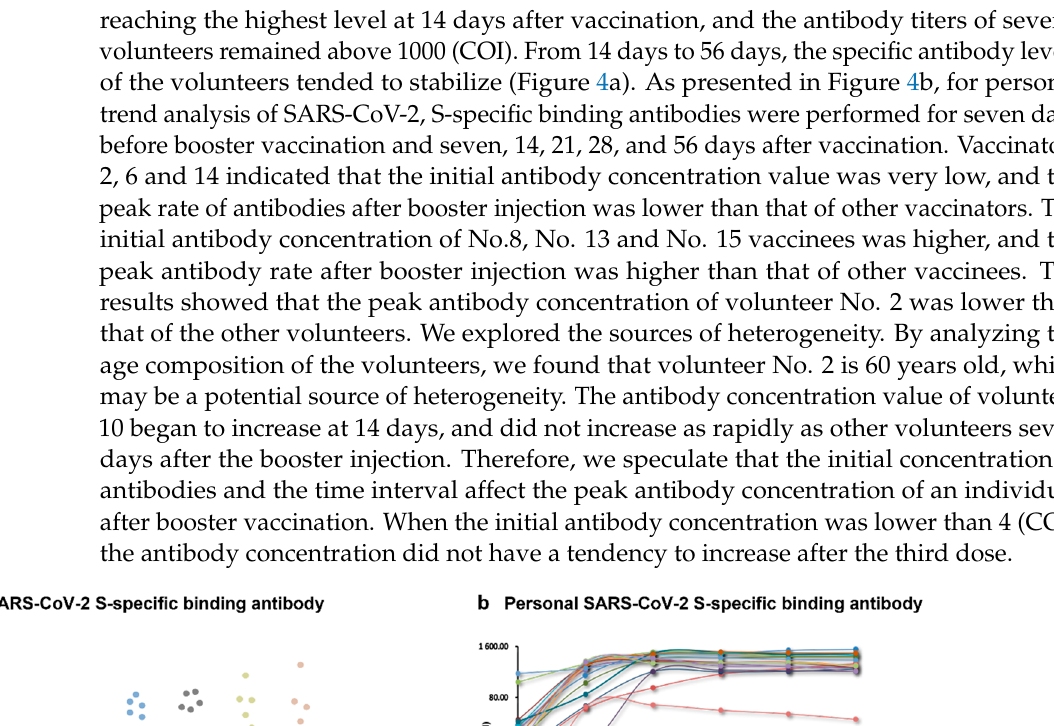
Figure 4. Antibody responses specific to SARS-CoV-2 vaccination in 16 volunteers. ( a ) The scatter chart is the antibody trend chart of the six time points before and after vaccination. I Bars indicate 95% confidence intervals. ( b ) The line chart shows the trend of antibody changes in 16 volunteers at six time points before and after vaccination, respectively; Y ‐ axis values are log 10 of antibody titer values.